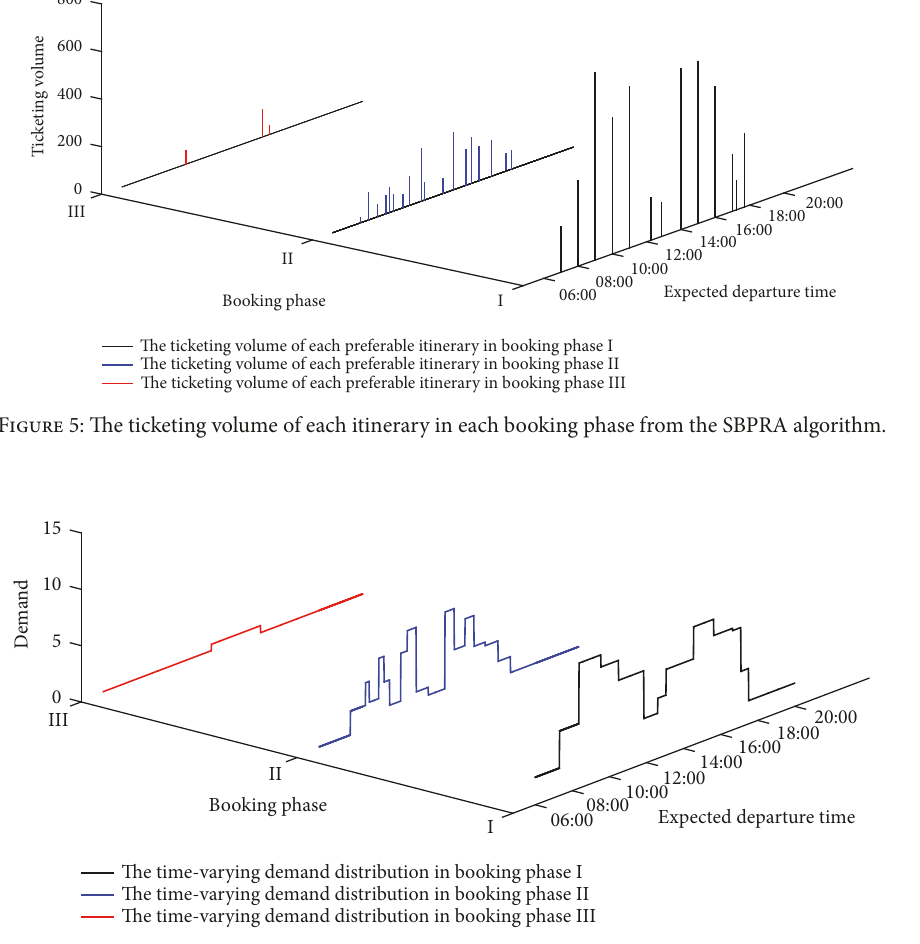
Figure 6: The time-varying demand distribution in each booking phase of the SBPRA